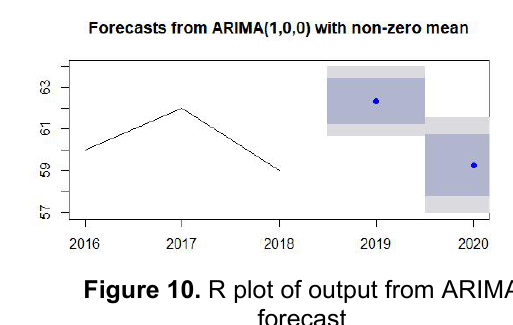
Figure 10. R plot of output from ARIMA forecast